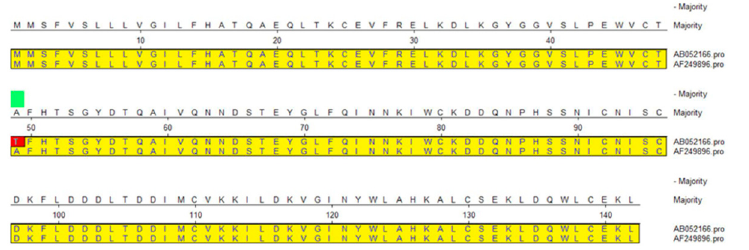
Figure 3. Bovine α -LA amino acid residue sequence alignment between Holstein (AB052166) and Bos Taurus (AF249896). Potential SNPs (562th, A/G) in the CDS2 region affects amino acid sequence changes (Ala/Thr) between Holstein and Bos Taurus (red marker).